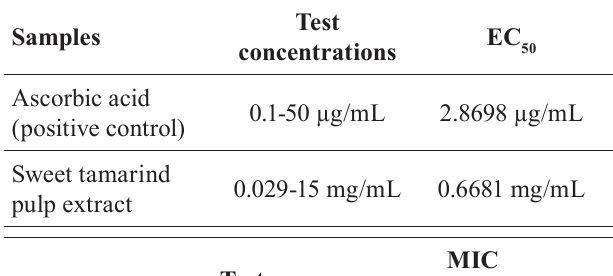
TABLE III - Antioxidant and antibacterial activities of sweet tamarind fruit pulp extract compared with positive